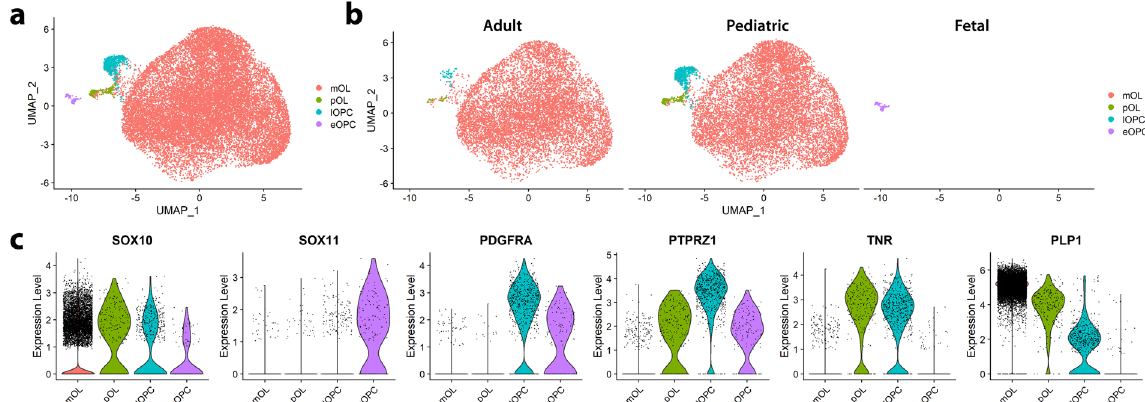
Fig. 2 Sub-populations of human OL lineage cells as de fi ned by whole scRNA sequencing. OL lineage cells derived from whole-cell sequencing of fetal, pediatric, and adult tissue samples cluster into distinct OL lineage subpopulations. a Uniform manifold approximation projection (UMAP) plots of pooled OL-lineage cells, visualizing 4 clusters: mOL, pOL, lOPC, and eOPC. Individual dots on UMAP plots represents single cells. b UMAP plots of OL-lineage cells split by age-group. c Violin plots showing relative expression level across clusters of selected marker genes, where expression levels are z-scored normalized average expression and gray dots indicate individual cells expressing the marker. Number of independent biological samples by age group: 4 adult, 7 pediatric and 4